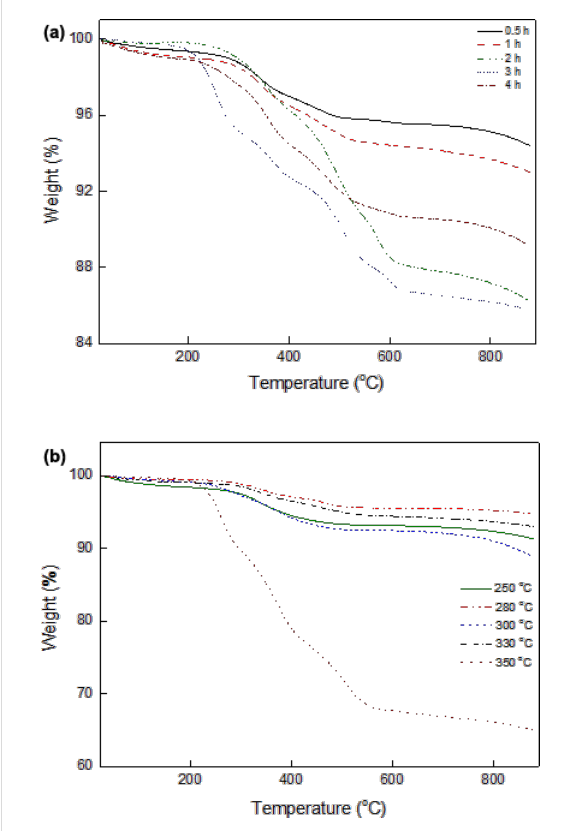
Figure 8: Energy-level diagram of Yb 3+ /Er 3+ and the upconversion mechanism at 980 nm excitation. The doted and dashed curves